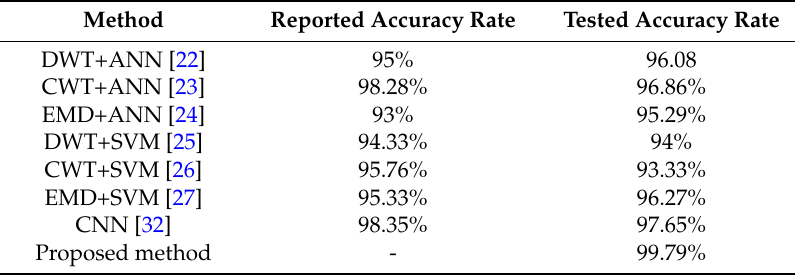
Table 4. Performance comparison with different method.